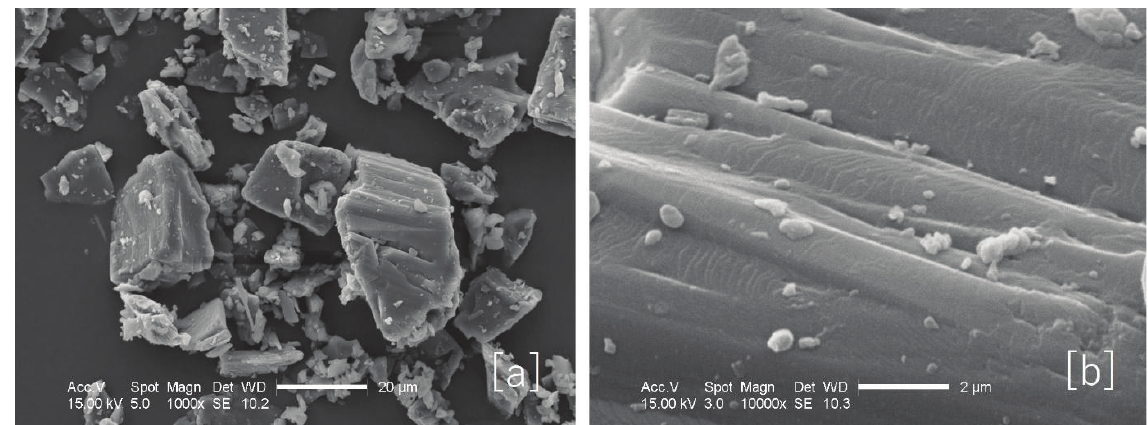
of the SOm grains, BSE, magnification: a) 1000x, b) 10000x Fig. 3 Surface